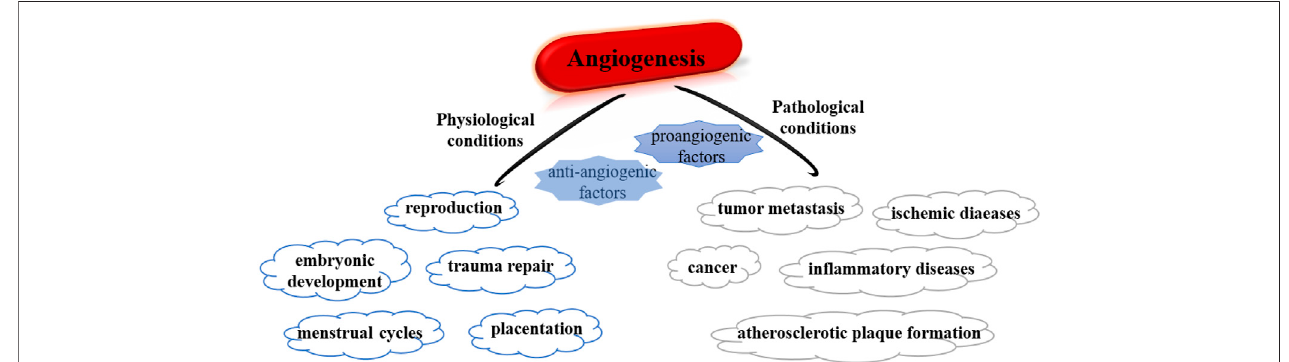
FIGURE 1 | Summary of roles of angiogenesis under physiological and pathological conditions.